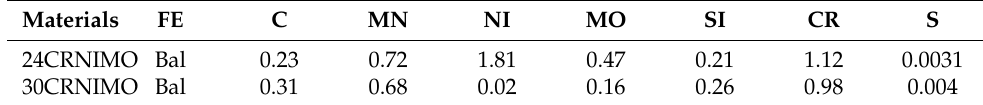
Table 1. Chemical composition of 24CrNiMo alloy steel and 30CrNiMo steel.